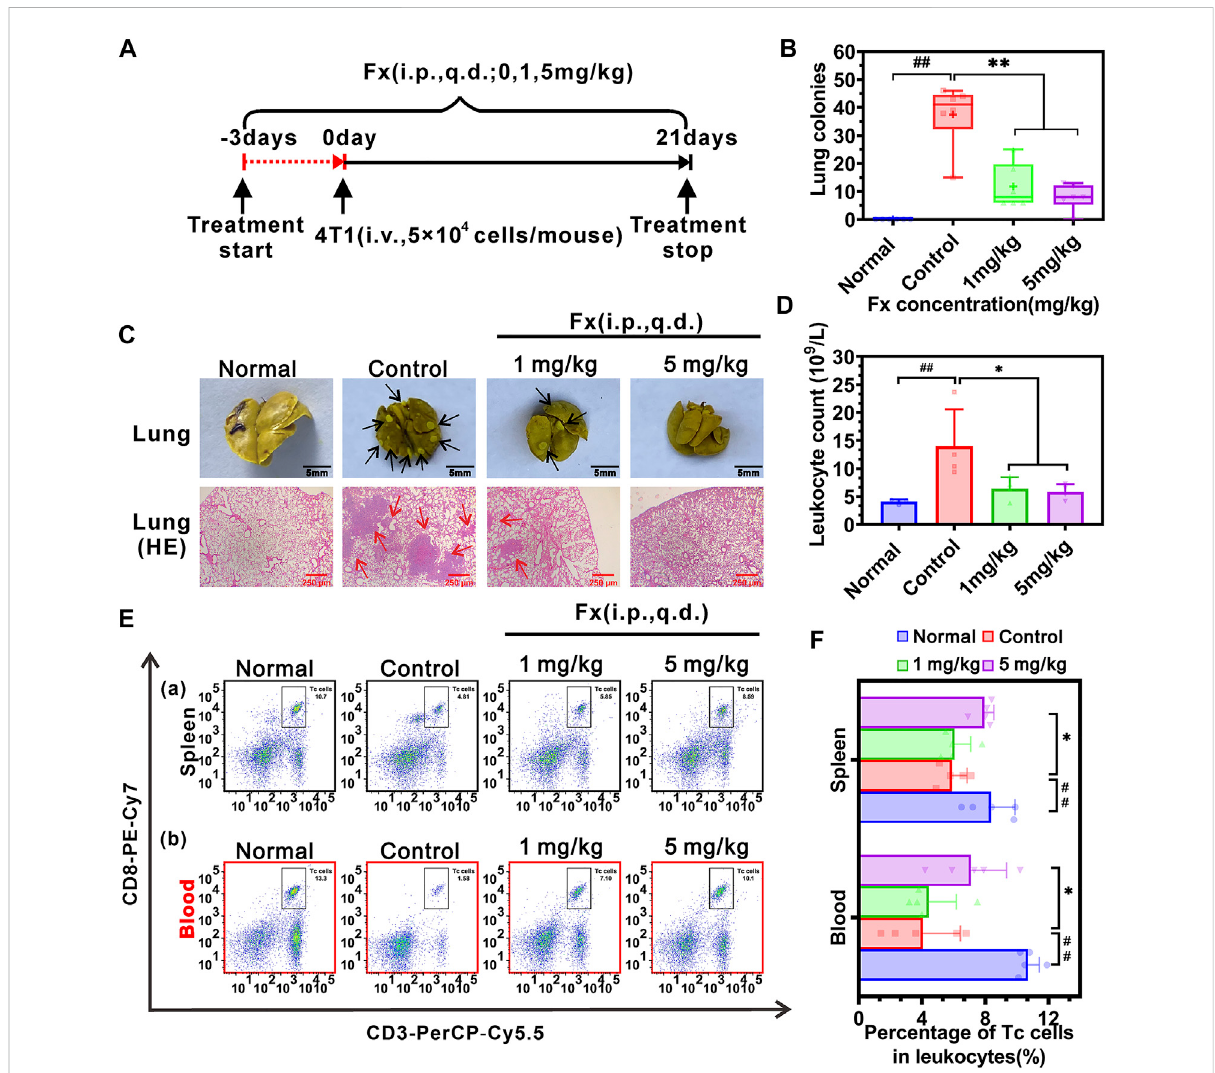
FIGURE 7 Effects of Fx in vivo breast cancer pulmonary metastasis in immunocompetent BALB/c mice. (A) Schematic diagram of the experimental protocol of Fx for treatment of cancer metastasis in vivo . Mice were pre-treated with Fx for 3 days (0 mg/kg, 1 mg/kg, 5 mg/kg, the volume of Fx is 100 μ l per mouse, i.p., q.d.) prior to inoculation with 4T1 cells (5 × 10 4 cells/mouse, tail vein injection), followed by continued treatment for 21 days. (B) Fx signi fi cantly decreased the number of pulmonary metastatic nodules in a dose-dependent manner. (C) Representative photos of the lungs showing surface metastasis and H&E staining in Fx-treated mice. The black arrows indicate the breast cancer pulmonary nodules, and the red arrows indicate the breast cancer metastasis area. (D) Routine blood tests showed that the Fx signi fi cantly reduced the number of leukocytes to the normal range. (E) The percentage of cytotoxic T lymphocytes (Tc cells, CD45 + CD3 + CD8 + ) in peripheral blood and spleen of mice was detected by fl ow cytometry. (F) Quantitative analysis showed that the Fx signi fi cantly increased the percentage of Tc cells in peripheral blood and spleen and approached the normal range. Data are presented as mean ± SD ( n = 6); * indicate p < 0.05, ** indicate p < 0.01 vs . Control (Pulmonary metastatic mice); # indicate p < 0.05, ## indicate p < 0.01 vs . Normal (Healthy